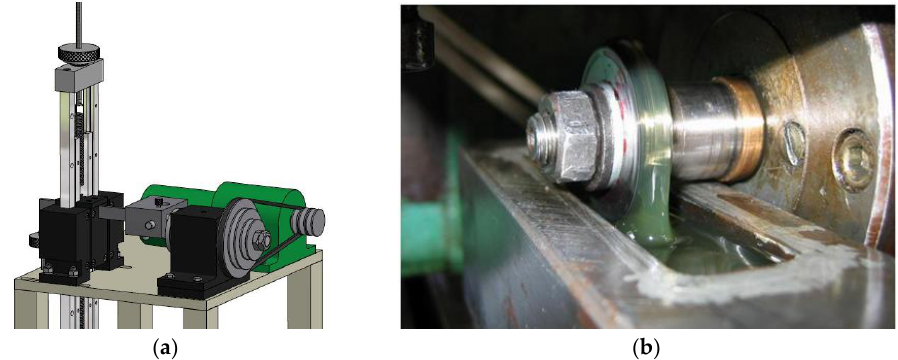
Figure 2. Tribometer ( a ) general appearance; ( b ) lubrication of the contact pair.